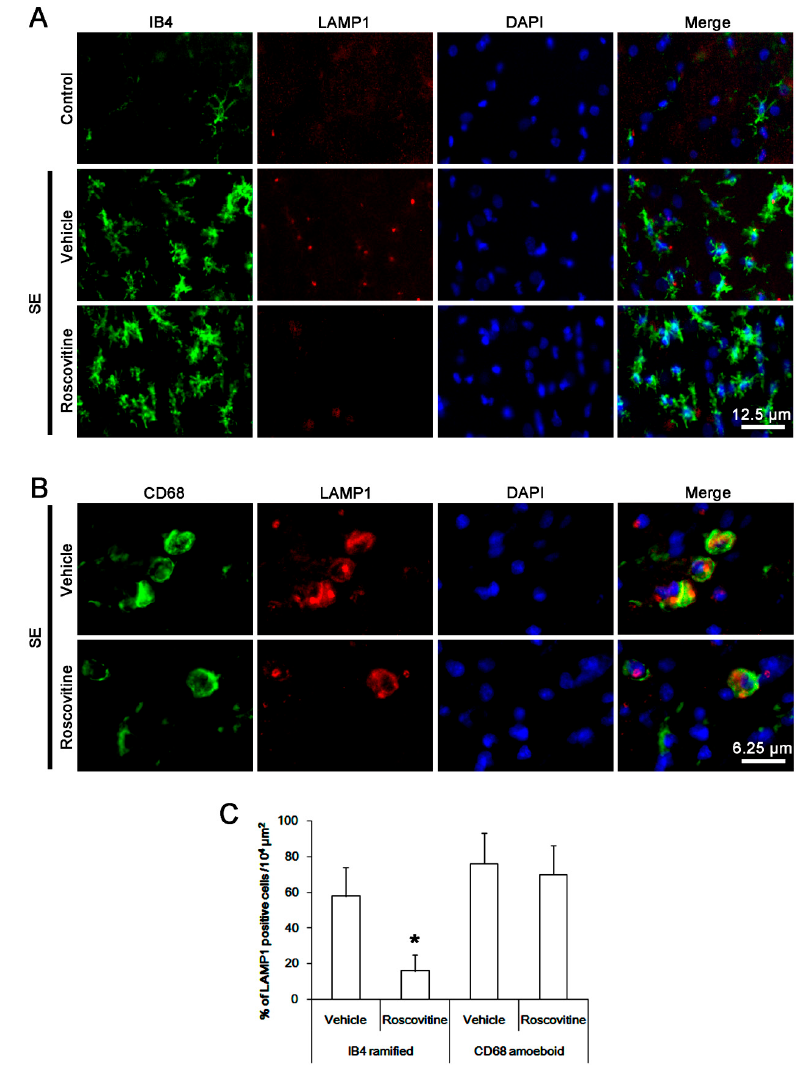
Figure 3. The effect of roscovitine on phagocytosis of resident microglia and monocyte following SE . Three days after SE, LAMP1 expression is significantly increased in resident IB4 ramified microglia and CD68 amoeboid cells in vehicle-treated animals, while it is rarely detected under physiological condition. Following SE, roscovitine alleviates the up-regulation of LAMP1 expression in IB4 ramified microglia, but not in CD68 amoeboid cells. ( A , B ) Representative images for LAMP1 expression in IB4 microglia and CD68 cells, respectively. ( C ) Quantification of the effect of roscovitine on LAMP1 expression in IB4 microglia and CD68 cells following SE. Error bars indicate SEM ( *p < 0.05 vs. vehicle-treated animals; n = 7, respectively).